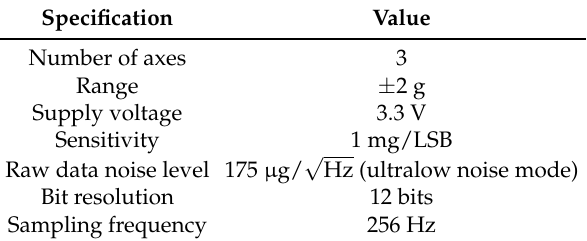
Table 1. Accelerometer